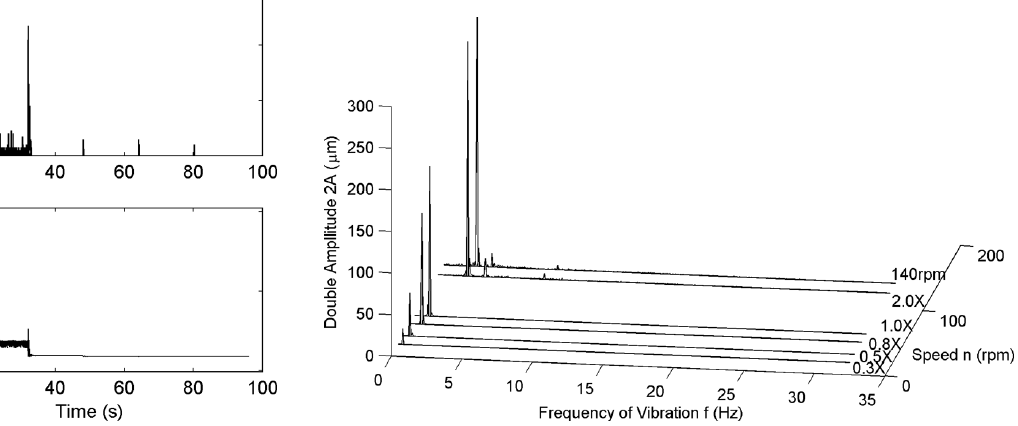
Fig. 8. The variation of iteration number and equiva- lent stiffness in the simulation of rotating speed test.